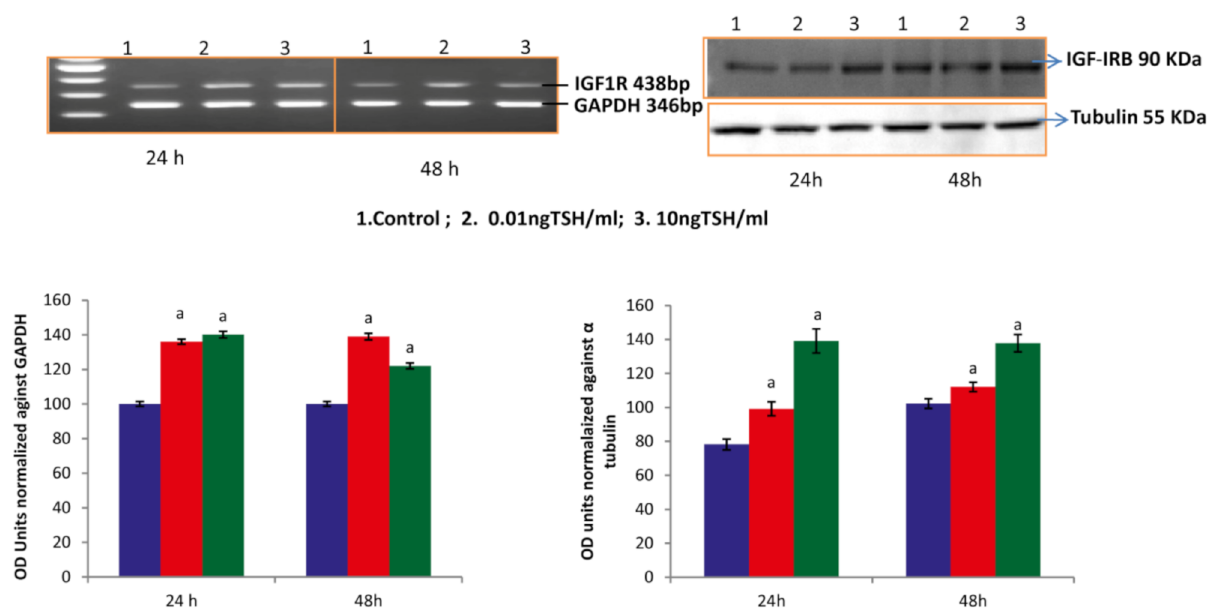
Figure 3. TSH influences expression of IGF-IRB in SaOS-2 cells. Each bar diagram shows mean ± SEM of three experiments; ‘a’ represents compared with control at p <